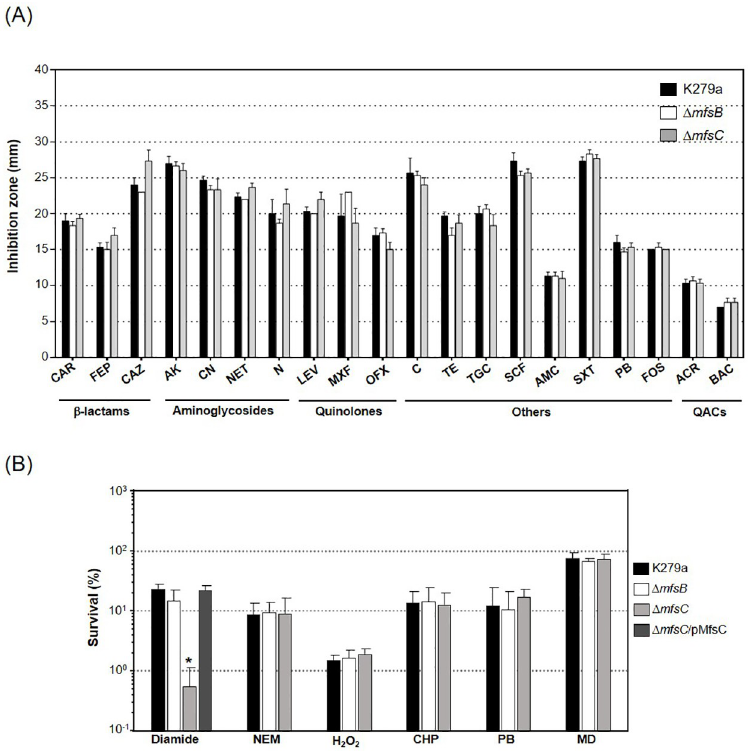
Fig 2. Phenotypic analysis of Δ mfsB and Δ mfsC mutant strains. (A) Antibiotic susceptibility of wild-type K279a (closed bar), Δ mfsB (open bar) and Δ mfsC (light-gray bar) mutant strains was determined using standard